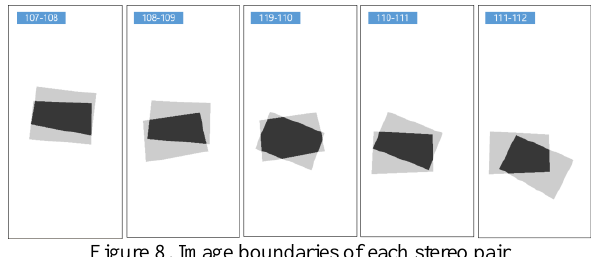
Figure 8. Image boundaries of each stereo pair